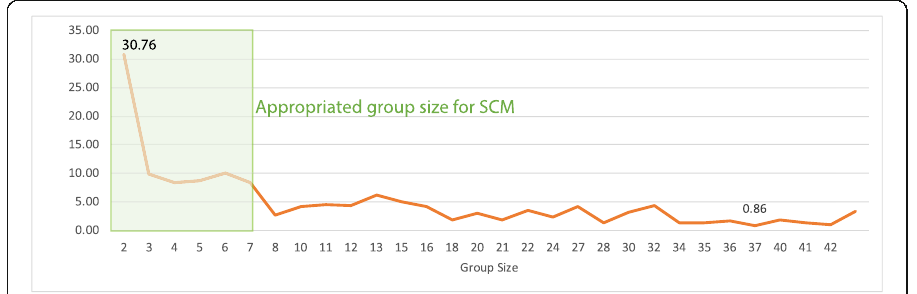
Fig. 8 Distribution of SCM group size and member